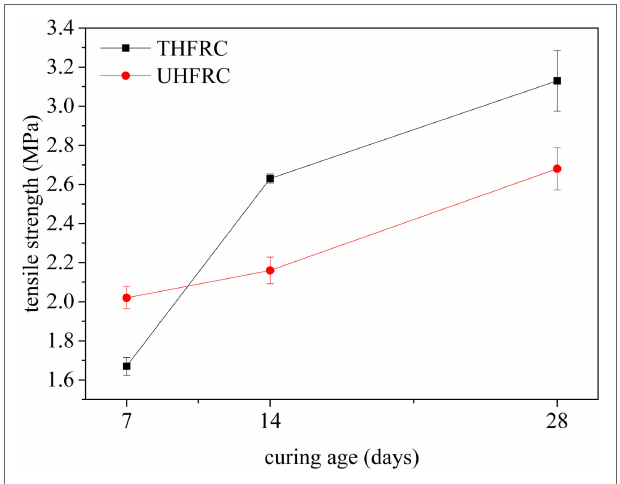
FIGURE 4 | Average tensile strength of specimens tested.